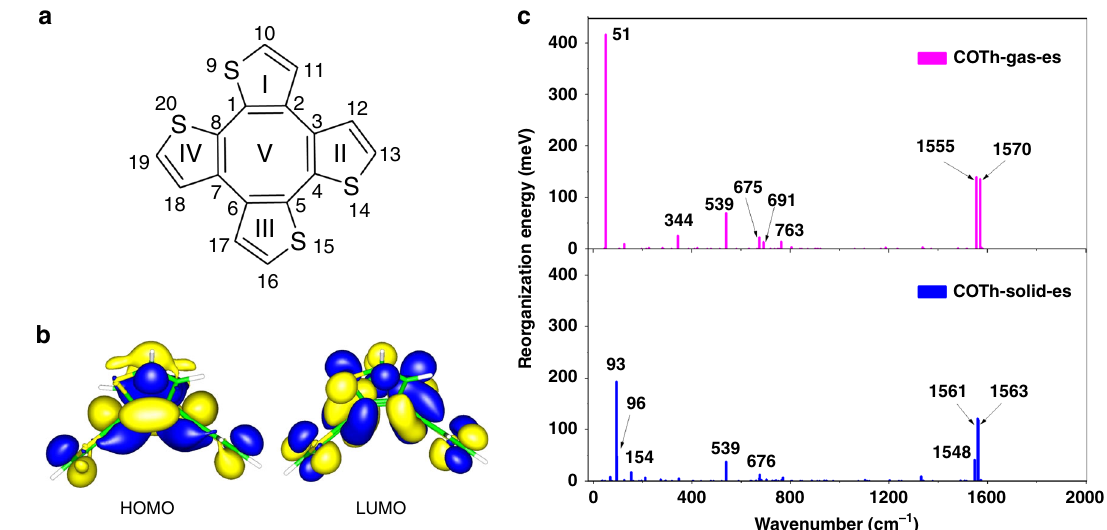
Fig. 4 Theoretical calculations. a The chemical structure of COTh, with both atoms in the backbone and fi ve rings labeled, respectively. b The electron density distributions of the molecular orbitals HOMO and LUMO of COTh molecule at the side view. c Plots of the calculated reorganization energies vs. the normal mode wavenumbers of COTh for the gas phase (upper panel) and the crystal structure (lower panel)